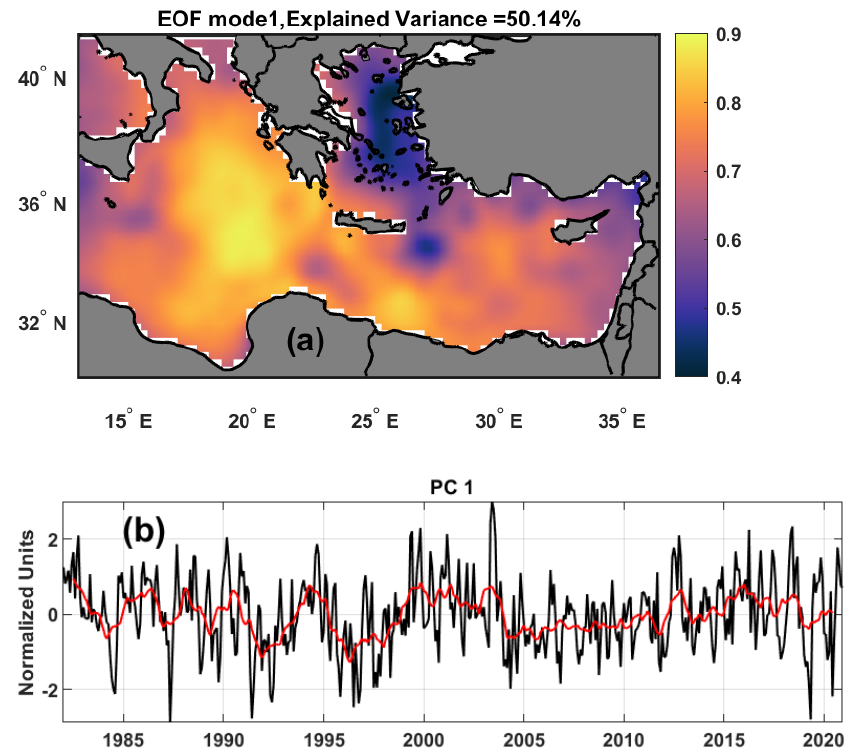
Figure 4. Spatial trend map of SST anomaly over the EMED from AVHRR during 1982–2020, after the seasonal cycle was removed at each grid point.